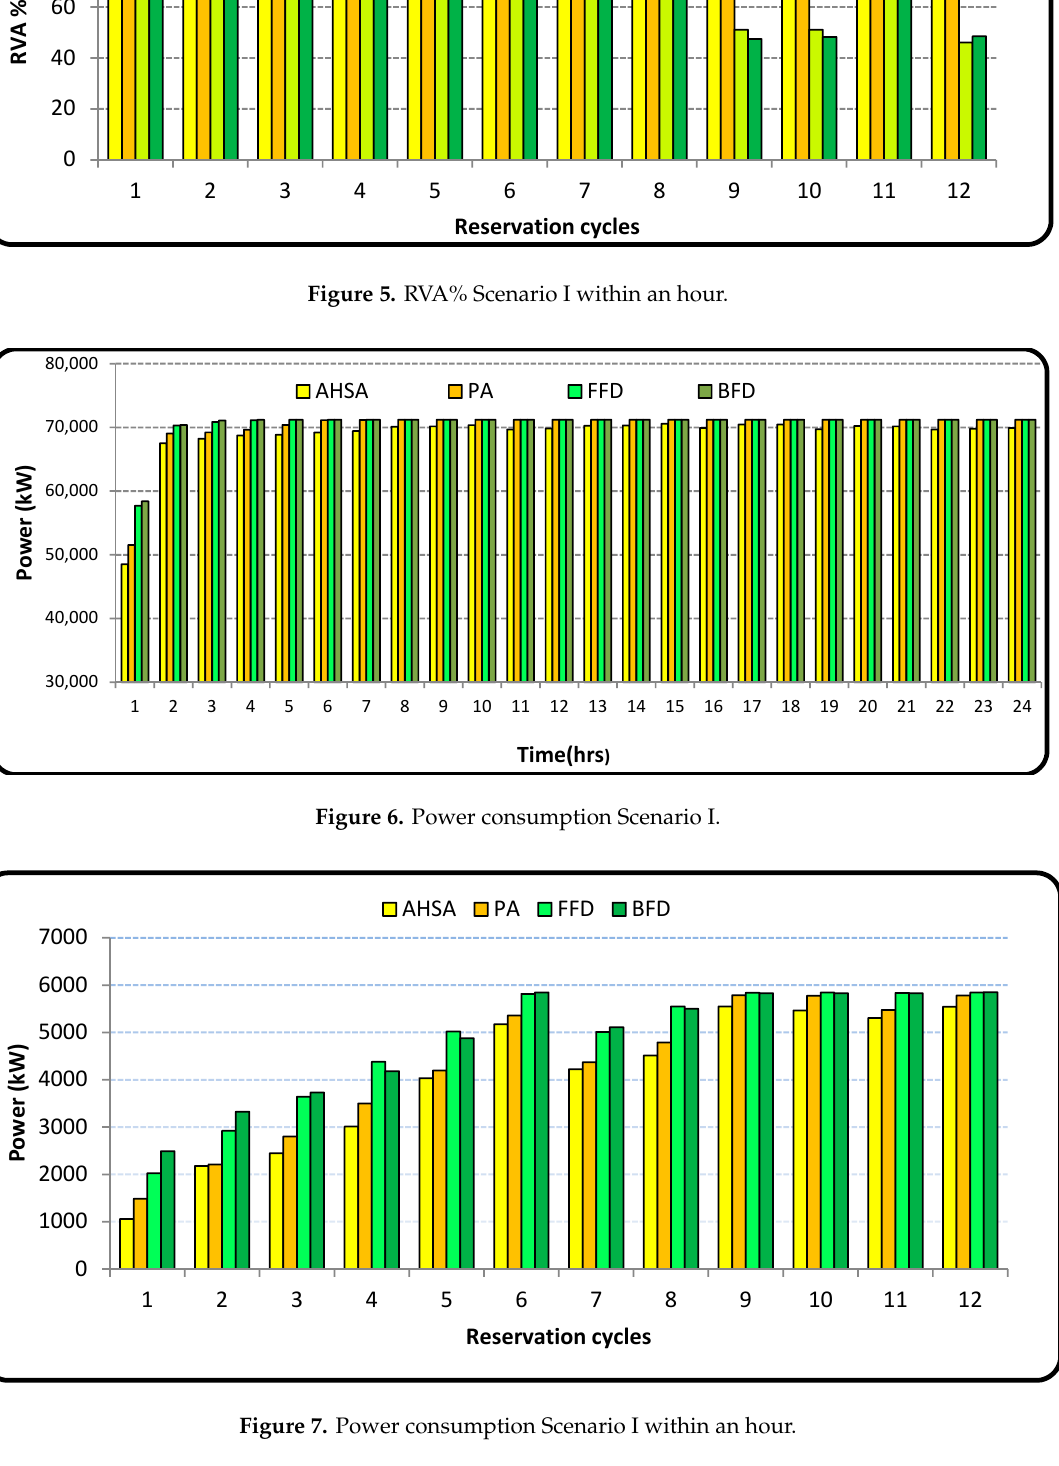
Figure 7. Power consumption Scenario I within an hour.